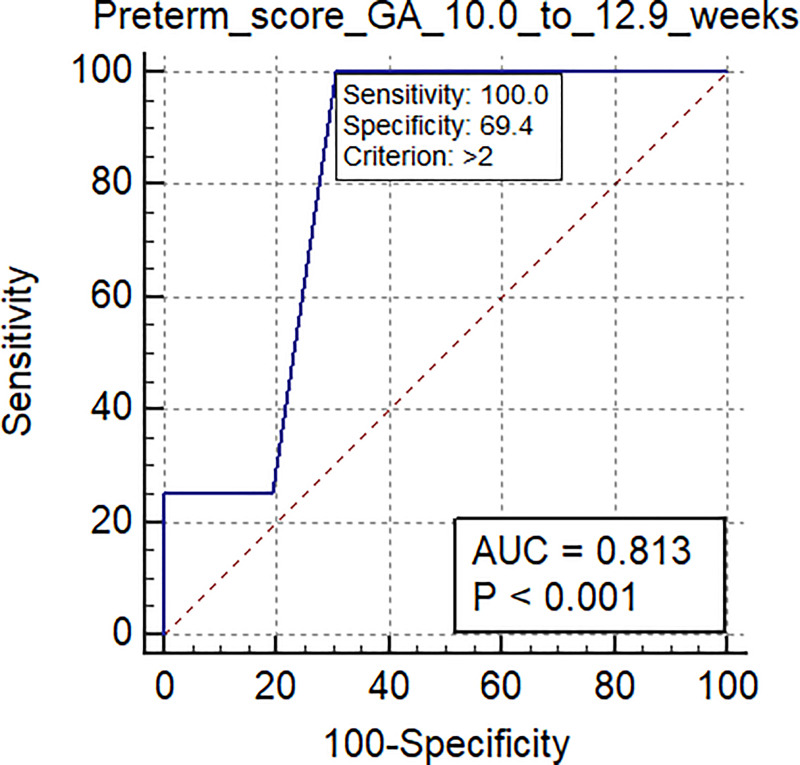
The AUC-ROC score for spontaneous preterm birth in the late first trimester time range (10.0–12.9 weeks gestational age; mean 11.5±0.8 weeks) was 0.81 (95% CI: 0.66 to 0.92; p<0.001) in the validation set.